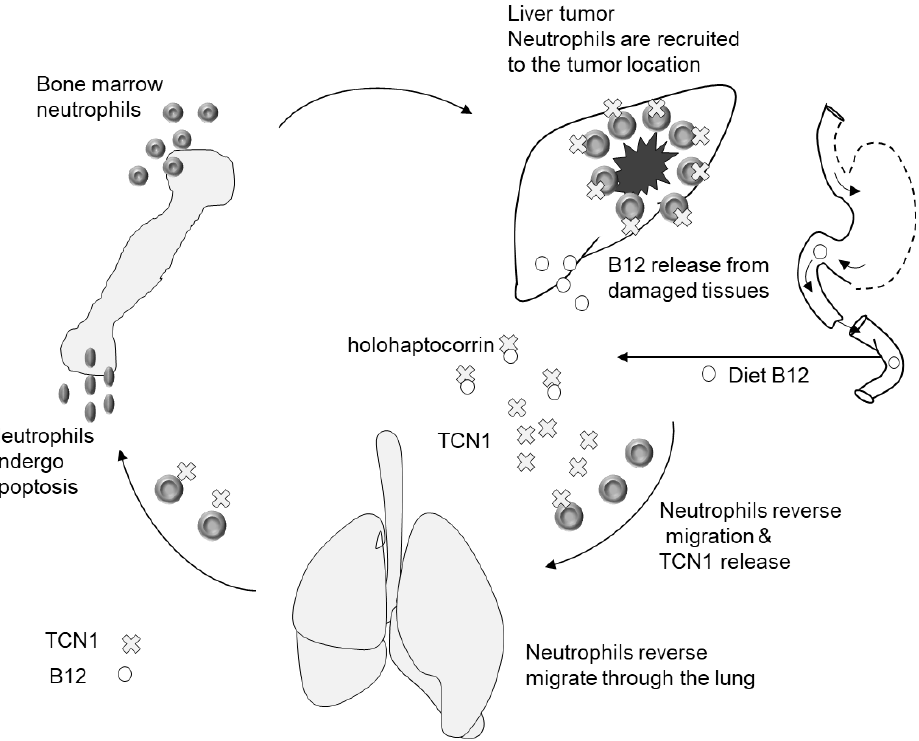
Figure 2. Possible pathomechanisms explaining elevated plasma vitamin B12 in patients with some cancers. Haptocorrin (TCN1) is overexpressed in cancer tissues and this expression is related to the stage of tumor, apoptosis, and inflammation processes. The short-living neutrophils originate from the bone marrow. The neutrophils express high level of TCN1 and are engaged in the body defense against cancer tumor. Neutrophils-originated-TCN1 may capture B12 and explain its retention in